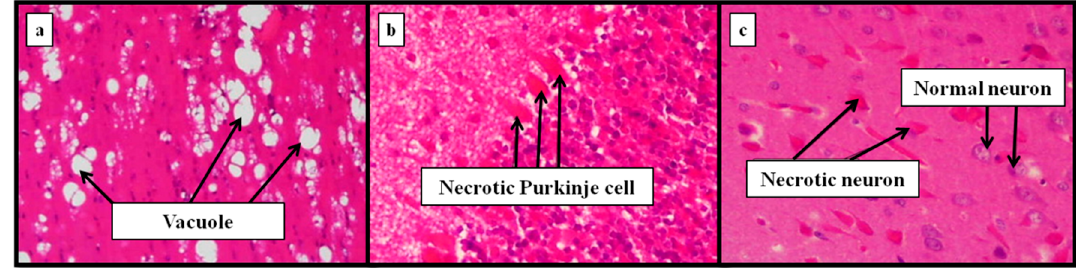
Figure 5. Histological examination of a mouse brain intoxicated with aluminum. ( a ) Spongiosis but no neuronal necrosis in the positive aluminum control mice; ( b ) necrosis in the cortex and in the cerebellum of aluminum-intoxicated animals treated with silicon; ( c ) necrosis of cortical neurons of animals treated with conjoint aluminum and beer [122] (Elsevier copyright license number: 4621240772368).